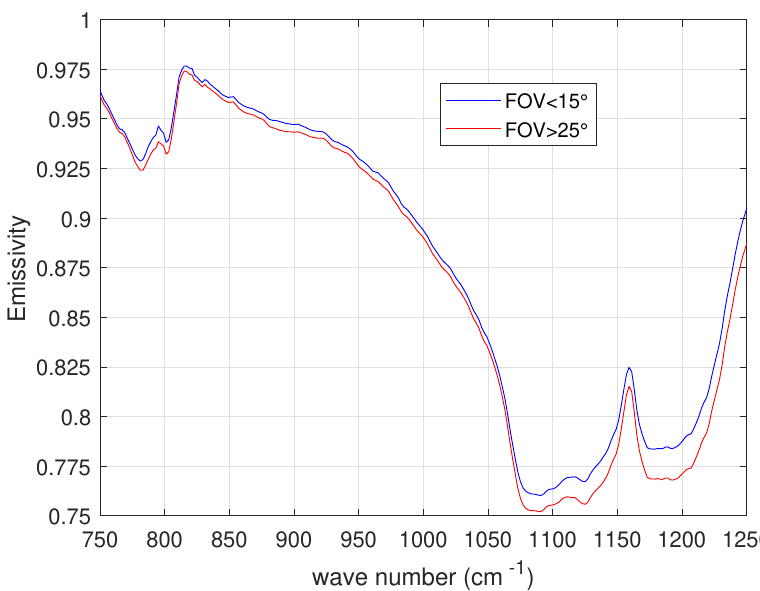
Figure 17. Exemplifying the angular dependence of emissivity on the angle of view. The figure shows the mean retrieval for a set of IASI soundings with FOVs smaller than 15 ◦ and larger than 25 ◦ . The set of soundings is that shown in Figure